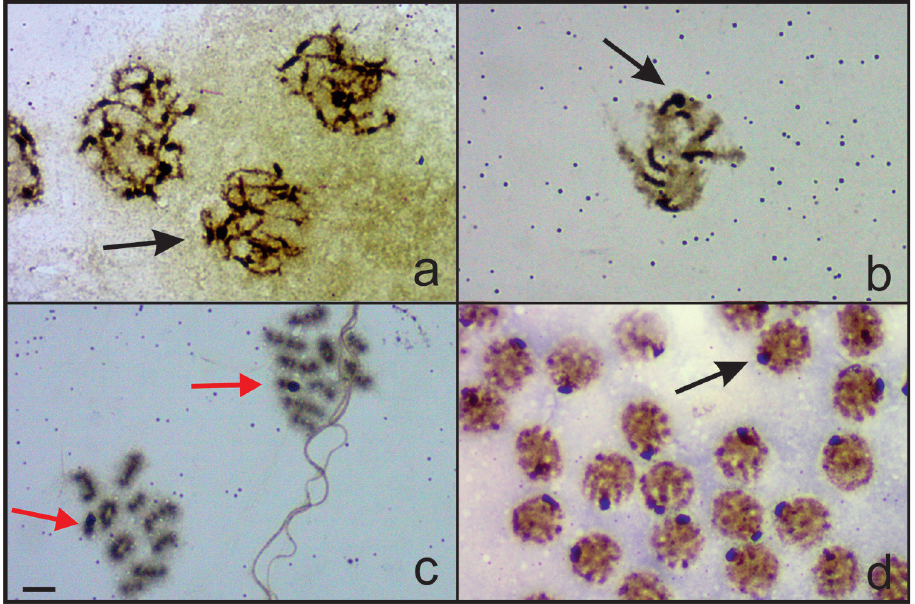
Figure 5. Silver nitrate staining a–c N. bozdagus d N. plebejus. Black arrows indicate NOR, red arrows indicate argyrophilic sex bivalents, Bar = 5